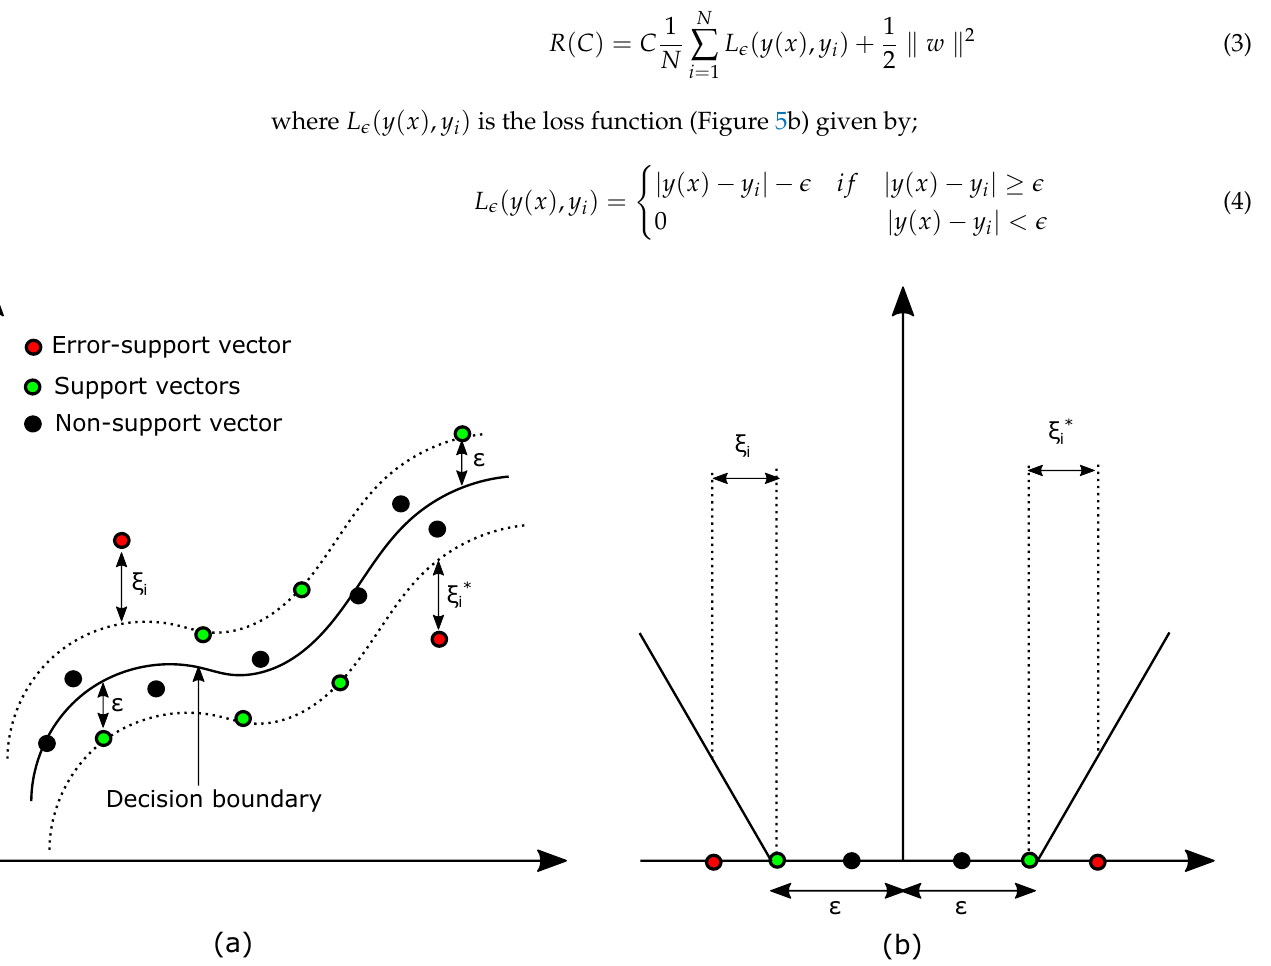
Figure 5. Schematic to illustrate ( a ) the conceptual structure of the support vector regression, ( b ) the loss function. The risk function (Equation (3)) is modified by introducing the relaxation variables